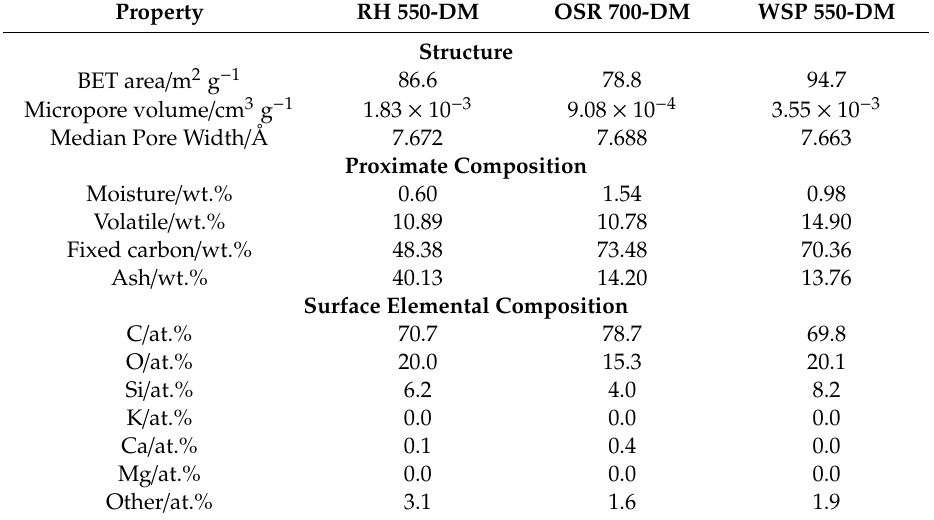
Table 3. Summary of the characterisation of demineralised (denoted by -DM) biochars from di ff erent feedstocks (rice husk (RH), oil seed rape (OSR) and wheat straw (WSP)). Shaded cells indicate that experimental data is not available. Results for elemental composition reported to one decimal